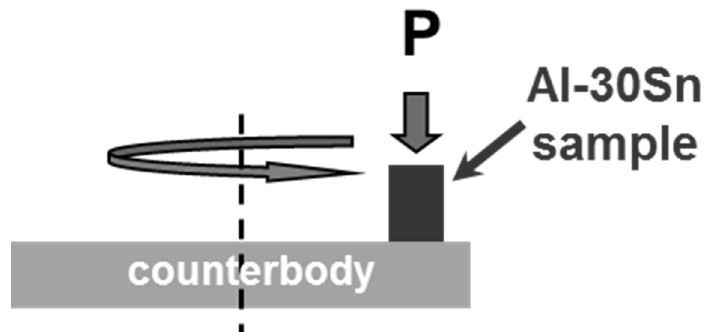
Figure 1. Scheme of the pin-on-disk testing of the investigated Al-30Sn composite against a steel